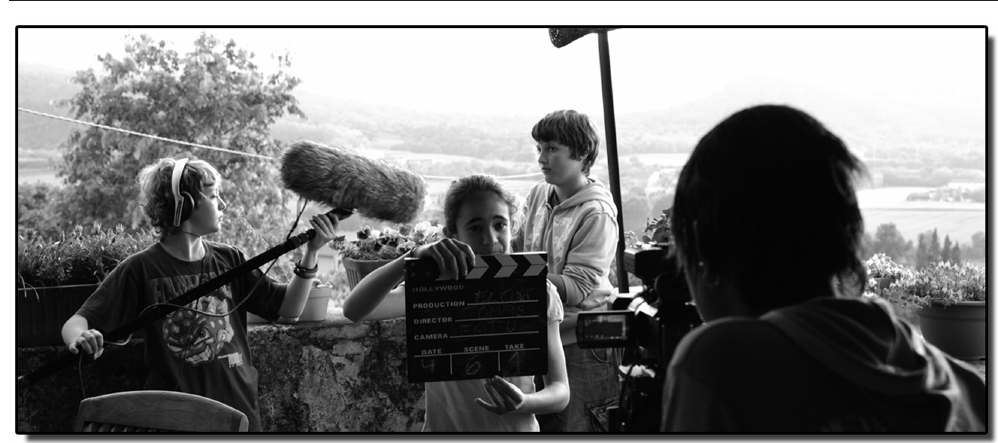
figure 3: Students shooting their final film (source: